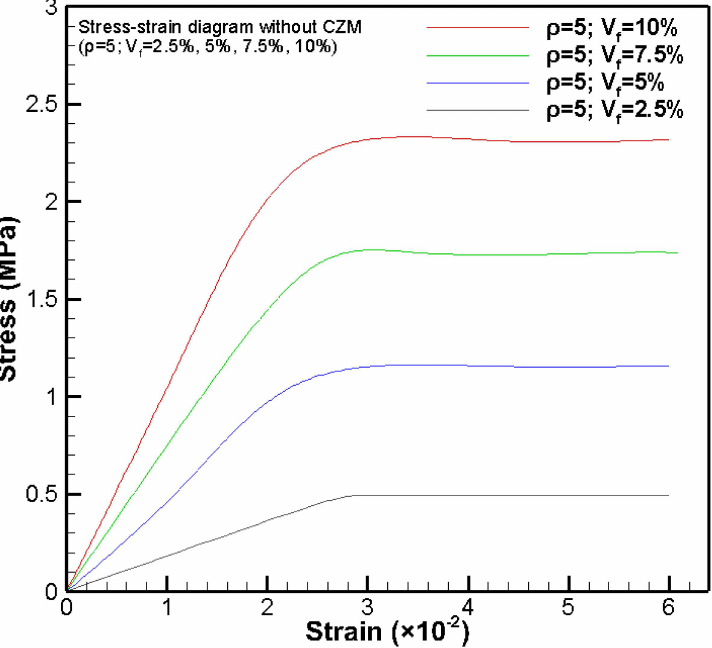
Figure 15. Effective stress-strain diagrams of the PNC (stack nanoparticle configuration) without CZM at the nanoparticle volume fraction of V f = 2.5%, 5%, 7.5%, and 10%, respectively ( ρ =